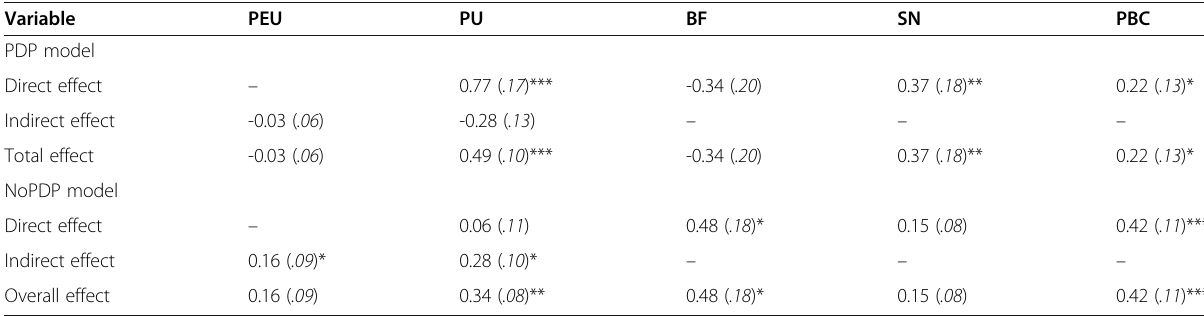
Table 6 Direct, indirect, and overall effects of the latent variables on BI by group